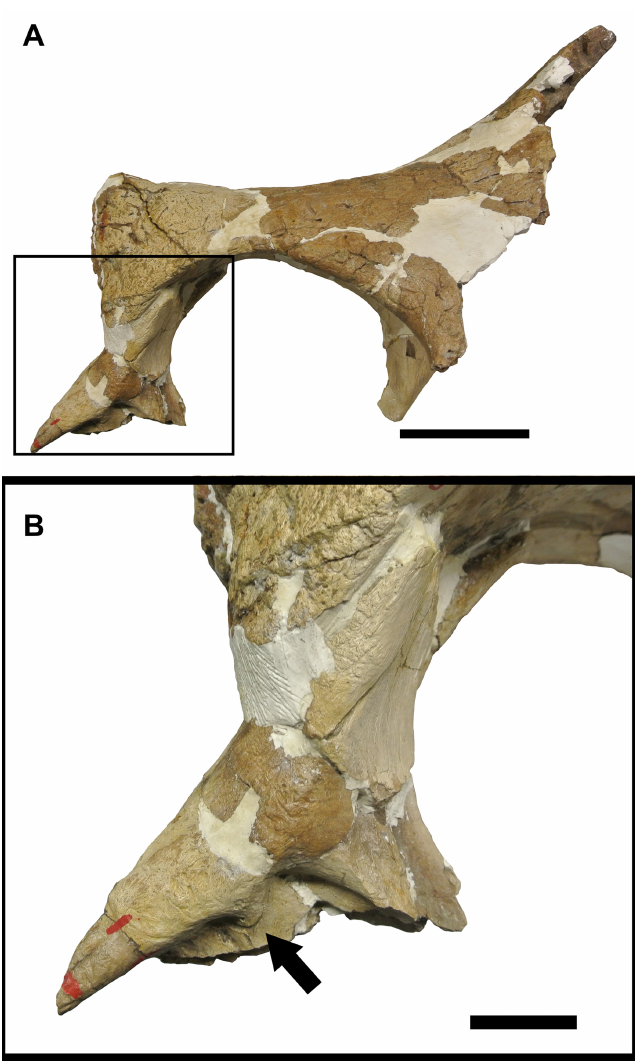
Figure 8. Nasal-premaxilla complex of YPM 1820, the holotype of Triceratops horridus . A) Box highlights partial premaxilla. Scale, 10 cm. B) Arrow indicates a strut directed into the interpremaxillary fenestra and positioned well ros - tral to the narial strut. Scale, 2 cm. Courtesy of the Division